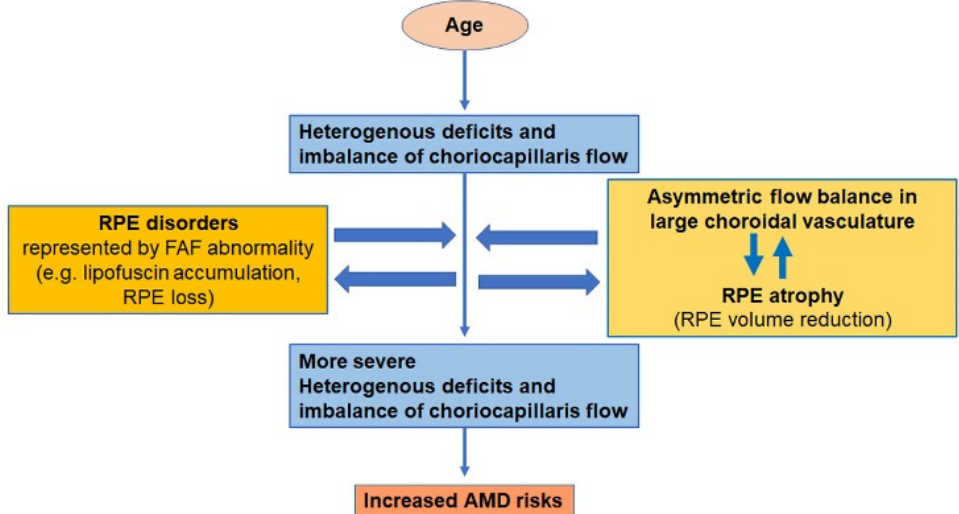
Figure 4. Hypothesis of the progression of heterogenous deficits and imbalanced choriocapillaris flow which increases the risk of age-related macular degeneration (AMD). Choriocapillaris flow deficits progress in a heterogenous manner with age. In addition, retinal pigment epithelium (RPE) changes, as detected by fundus autofluorescence, and in the presence of an asymmetric flow balance in the large choroidal vasculature, reduce the RPE volume measured with optical coherence tomography promote the deficits. Choriocapillaris flow and the RPE condition may interact to advance the heterogenous choriocapillaris flow deficits, which may increase the risk of AMD.